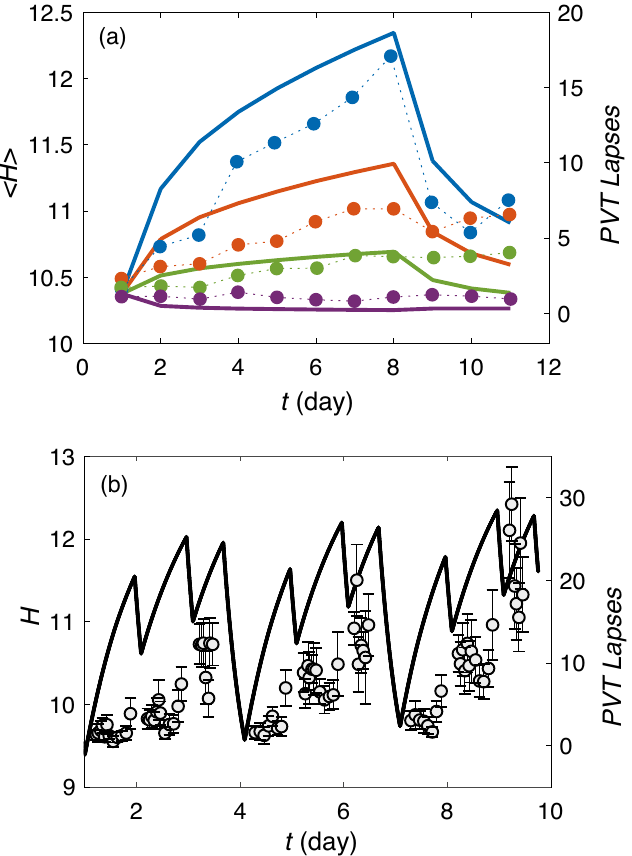
Figure 4. Model predictions for CSR protocols that were not used in parameter calibration. ( a ) Belenky et al. 24 chronic sleep restriction and recovery, averaged across each cycle with two-species parameters from Table 1. Blue indicates 3 h of chronic sleep restriction, red 5 h, green 7 h, and purple 9 h. Filled circles show the experimental data. ( b ) St. Hilaire et al. 25 chronic variable sleep restriction for two-species parameters from Table 1. Model prediction of H dynamics are shown with solid line. Experimental data are shown with gray